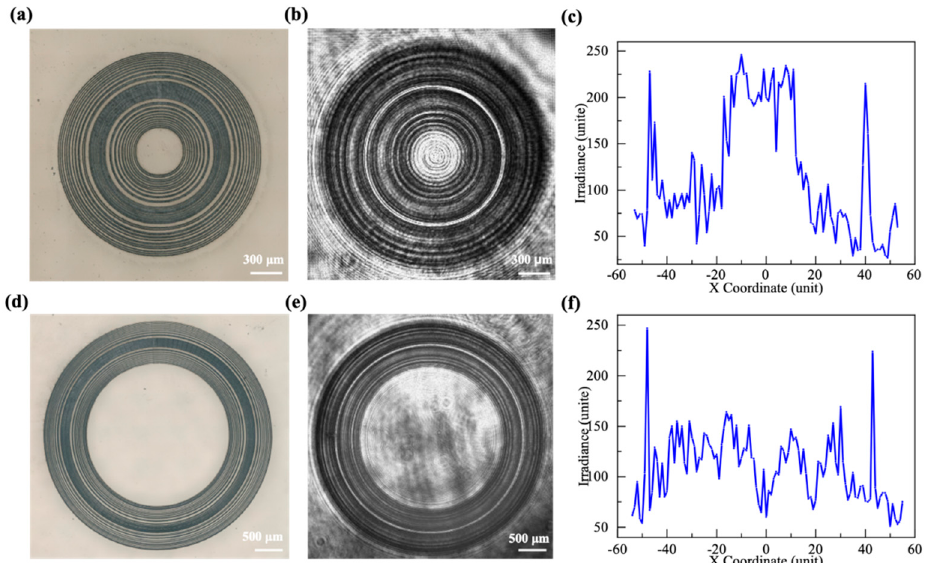
Figure 9. AFZP with R of 0.6 mm with central spots: ( a ) the AFZP prepared by a femtosecond laser on a fused silica sample; ( b ) the focusing ring behind the AFZP photographed by a CCD; ( c ) the energy distribution diagram of the focal plane, for the AFZP with R = 1.6 mm without central spots; ( d ) the AFZP prepared by a femtosecond laser on a fused silica sample; ( e ) the focusing ring behind the AFZP photographed by a CCD; ( f ) the energy distribution diagram of the focal plane.